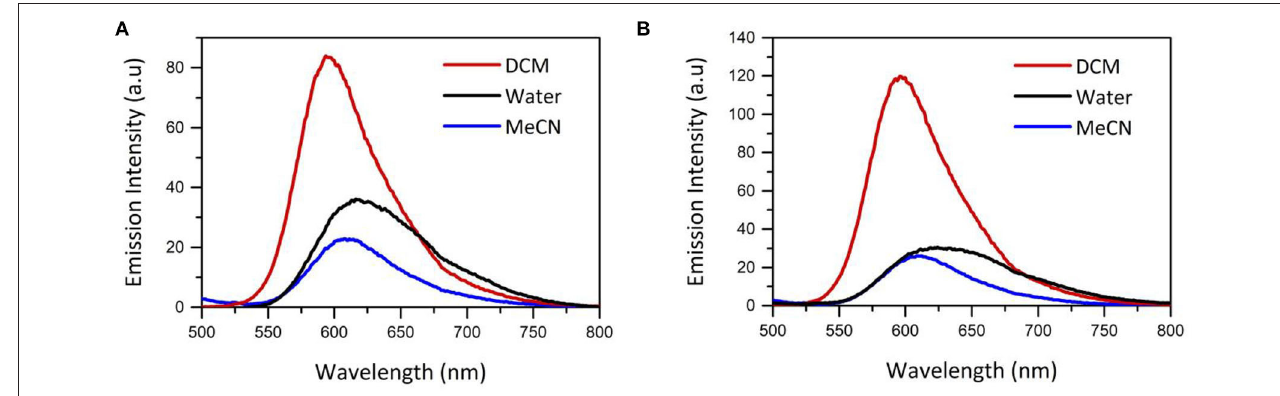
FIGURE 2 | Impact of solvent on emission spectrum of (A) [Ru(dpp) 2 (16-ATAP)] 2 + (B) [Ru(dpp) 2 (6-ATAP)] 2 + shown in MeCN, DCM and H 2 O. Concentration of Ru(dpp) 2 (16-ATAP)] 2 + is 5 × 10 − 6 M in all solvents. Excitation wavelenght = 454nm. n = 3.